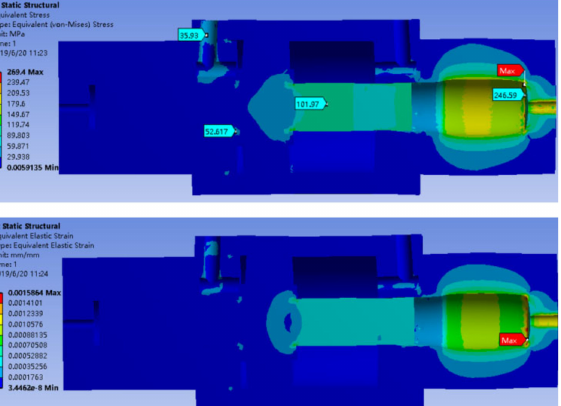
Figure 11. Stress analysis cloud and strain analysis cloud diagram when the piston is at the leftmost